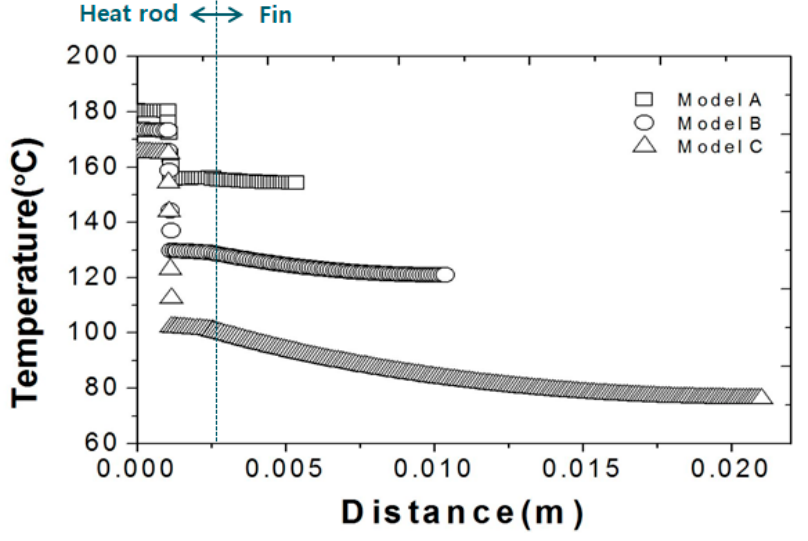
Figure 6. Temperature distribution of fin (Vertical direction).